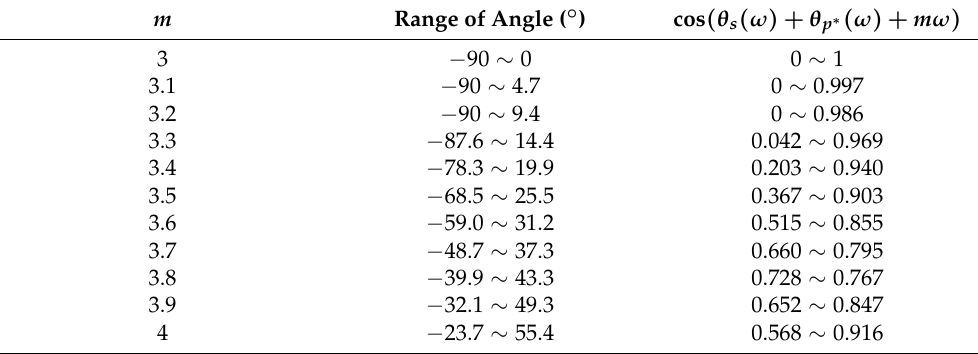
Figure 5. [ θ s ( ω ) + θ p ∗ ( ω ) + m ω ] phases when m changes from 3 to 4. Table 1. Values of cos [ θ s ( ω ) + θ p ∗ ( ω ) + m ω ] when m changes from 3 to 4 within the cutoff frequency of 1